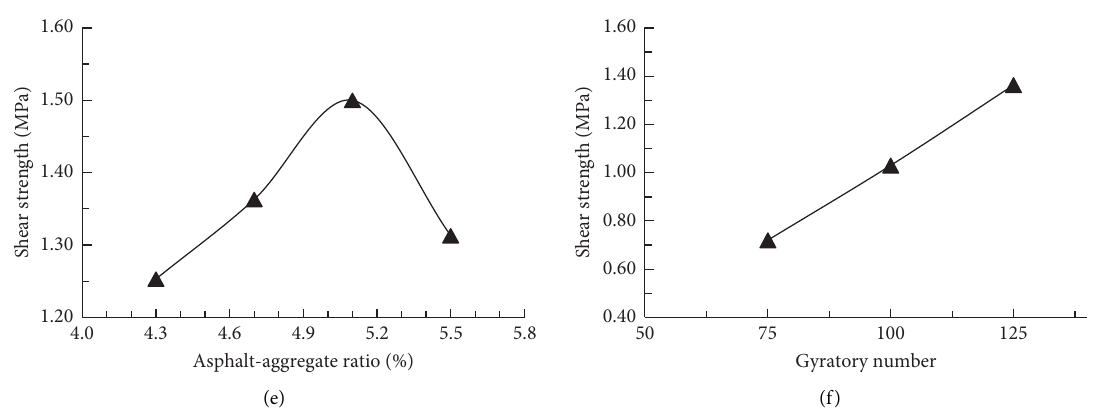
Figure 2: Effects of different modeling parameters on the shear strength. (a) Effects of aggregate surface energy on the shear strength. (b) Effects of Jnr3.2 on the shear strength. (c) Effects of GI on the shear strength. (d) Effects of specific surface area on the shear strength. (e) Effects of asphalt-aggregate ratio on the penetration strength. (f) Effects of the gyratory number on the shear strength.